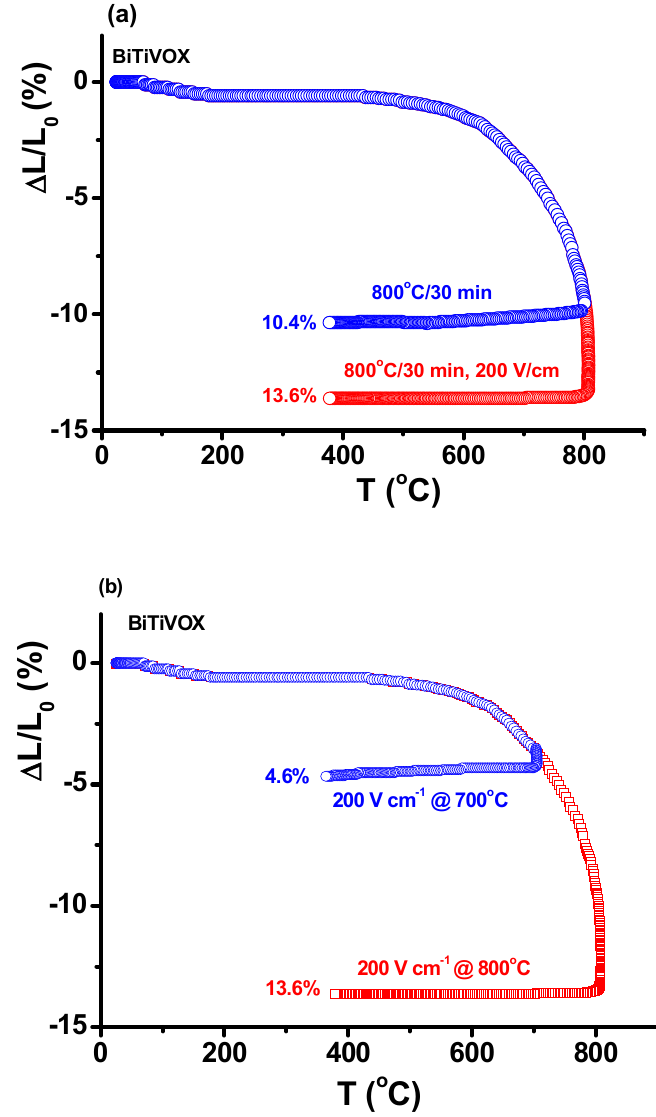
Figure 3. Dilatometric curves of BITIVOX ceramic pellets: ( a ) heating to 800 ◦ C / 30 min without and with application of 200 V cm − 1 during 5 min at 800 ◦ C; ( b ) applying 200 V cm − 1 at 700 ◦ C / 5 min and at 800 ◦ C / 5 min.